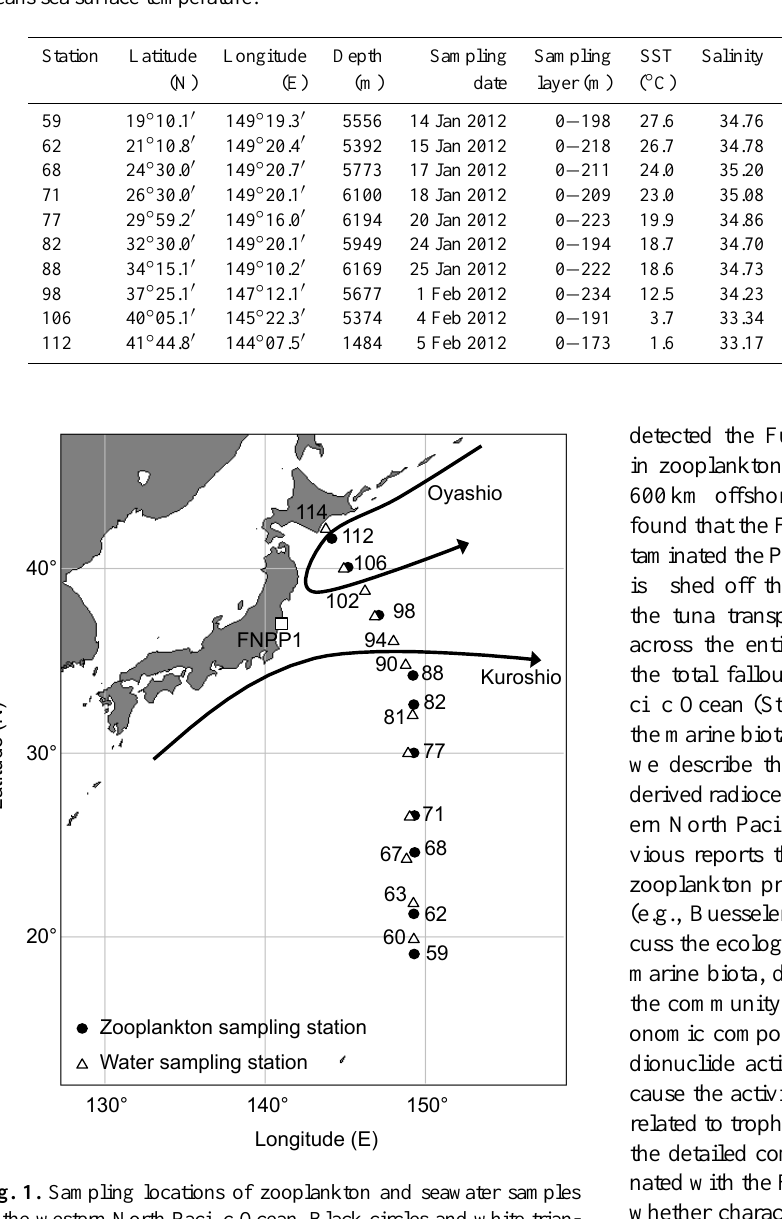
Fig. 1. Kitamura et al.